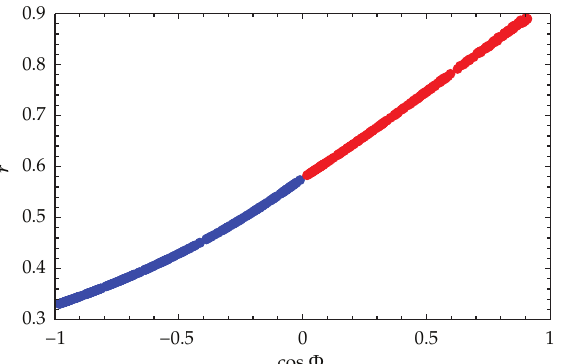
Figure 4: Allowed parameter region by the 1 σ experimental constraints (cid:2) 2.9 (cid:3) for the ratio r (cid:7) b/a as a function of cos φ . The blue (cid:2) dark (cid:3) and red (cid:2) light (cid:3) curves correspond to the IH and NH ordering.